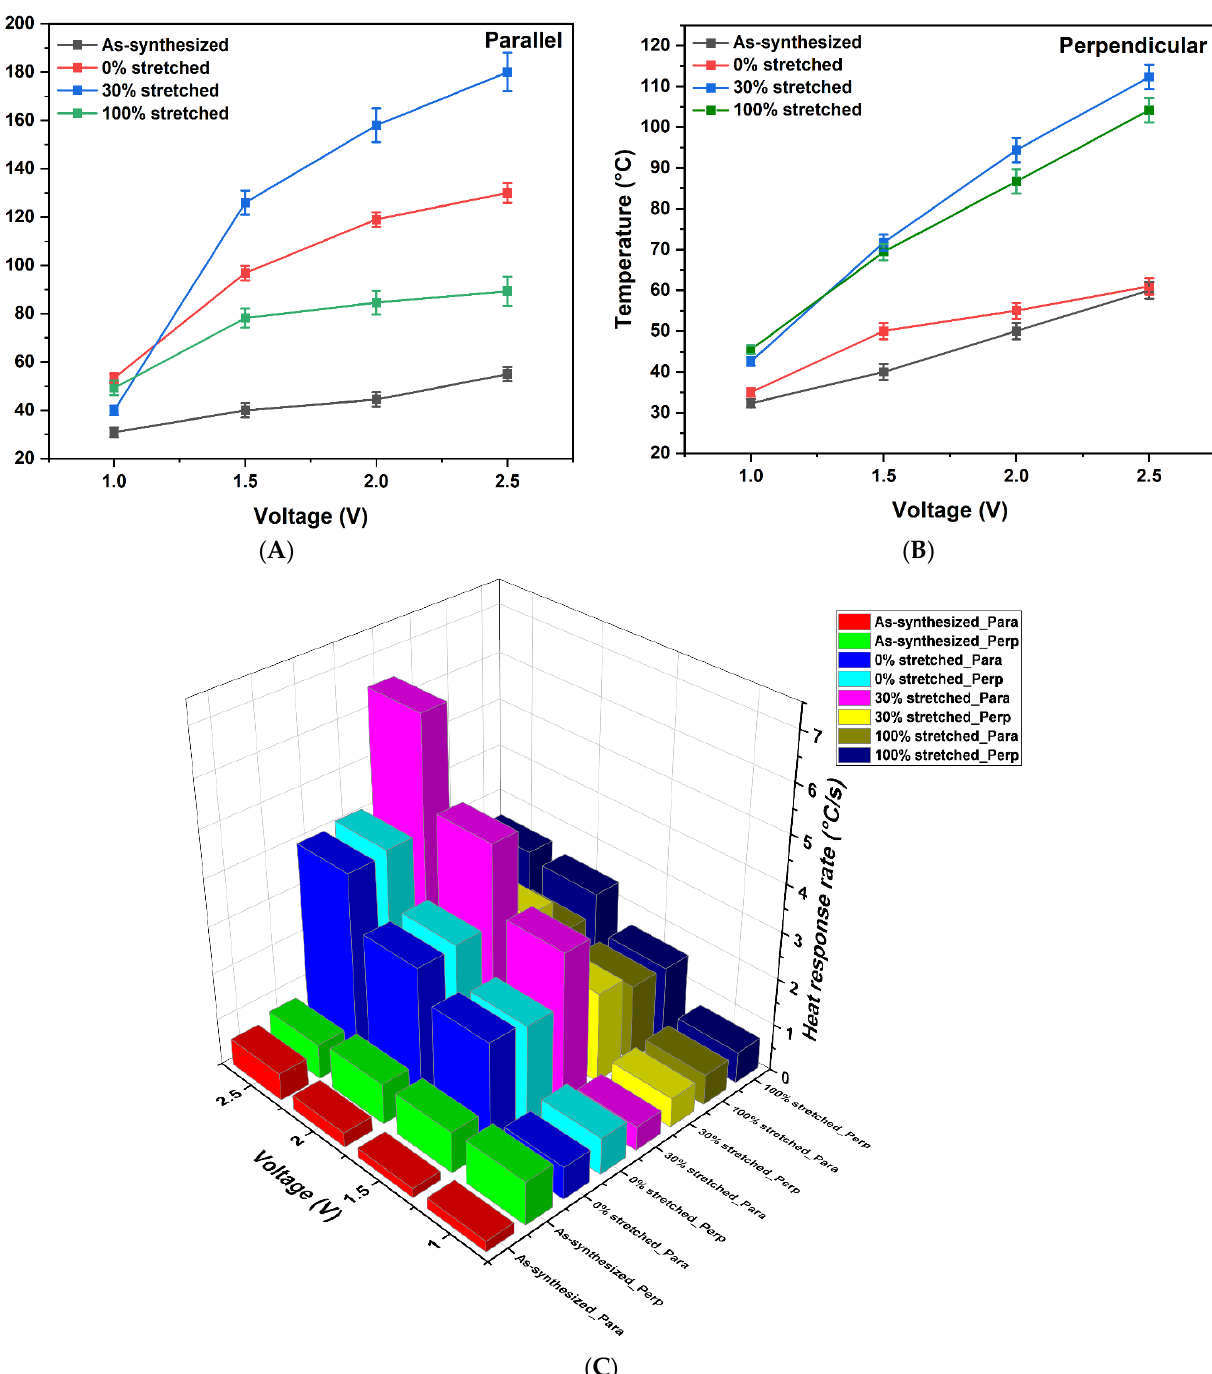
Figure 4. Heating performance of as-synthesized and CSA-stretched CNT samples from 1 V to 2.5 V in parallel direction ( A ) and perpendicular direction ( B ) , as well as the heating response rate of these samples in both directions ( C ).